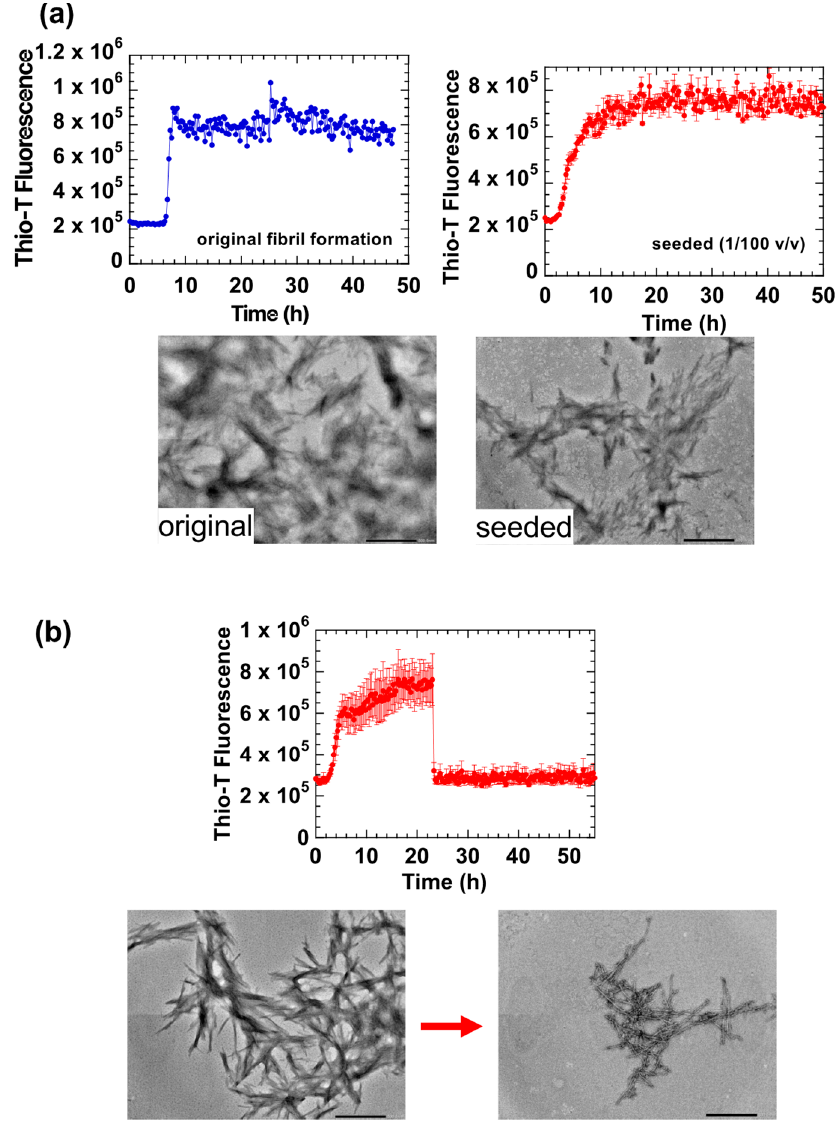
Figure 4. Seeded fibrillation experiments of HdeB performed at pH 2.0. ( a ) Seeds of “Form II” HdeB fibrils shorten the apparent lag phase of the fibril forming reaction, resulting in the production of “Form II’” fibrils. Initially, HdeB was incubated with shaking at pH 2.0 for 48 h (left, blue trace) to create Form II fibril samples. Next, an aliquot of this sample was added to freshly prepared acid denatured HdeB samples (1/100 v/v seeded assay) and fibrillation was allowed to proceed under the same conditions (right, red trace). Note the shorter lag time of the red trace compared to the original blue trace, which may be attributed to the presence of a fibril starter seed. Additionally, note that the left blue trace is the raw data of one sample that was subsequently used to provide seeding samples for the right red trace, and is therefore not an averaged data trace. TEM images of representative aliquots sampled at 48 h for each trace are shown below the time course panels. Images were obtained at ×20,000 magnification (scale bar; 500 nm). ( b ) pH shift experiments of Form II’ HdeB fibril samples. Form II’ HdeB samples were prepared and monitored for fibril formation according to the method used to obtain the red trace in ( a ). The pH of each sample was subsequently shifted to 7.0 at t = 24 h by addition of Tris base. Samples for TEM analysis were taken before and after the pH shift to obtain the images shown below the trace panel. Note that a significant amount of fibril matter remained under conditions where Form II HdeB fibrils would resolubilize (after a 24 h interval at pH 2, c.f . Figure 3a, red trace).